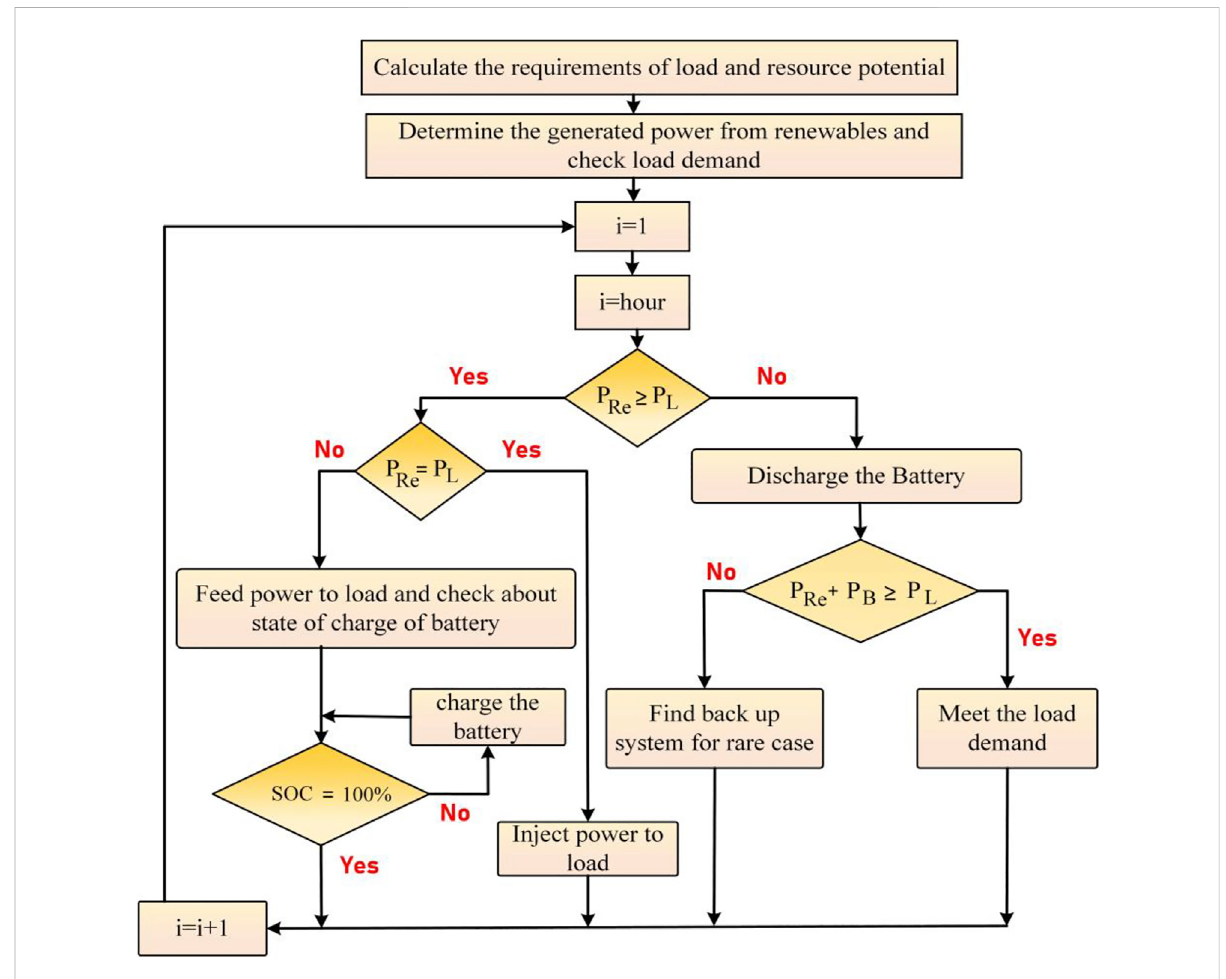
FIGURE 5 Diagrammatic representation of load following dispatch